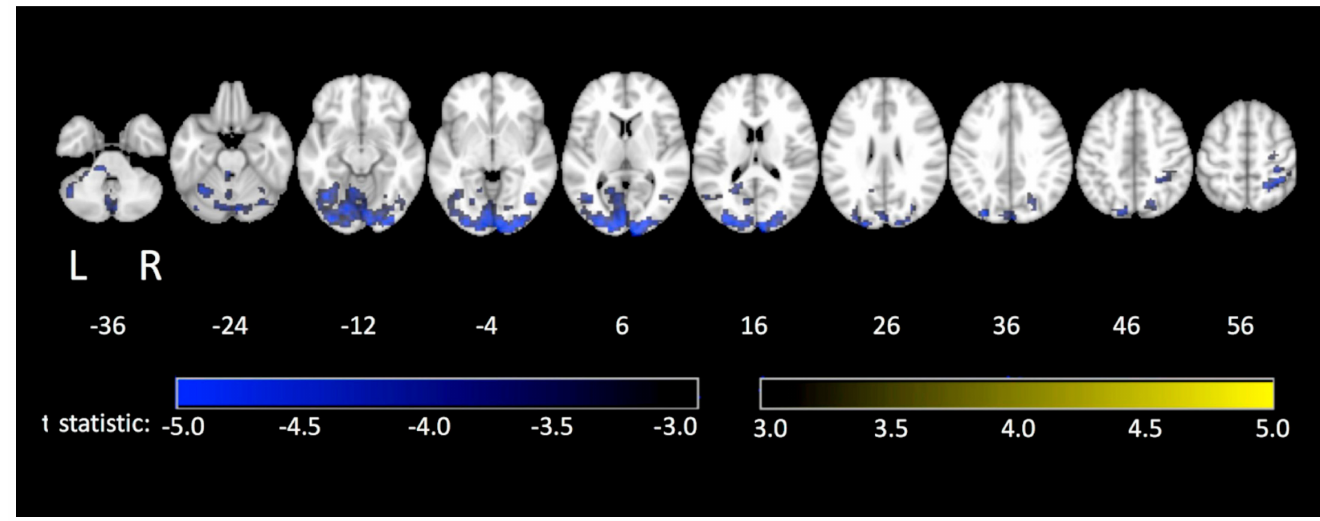
Figure 6. Regions with brain activity (TMT-A and TMT-B vs. control) that significantly covaries with age in a cohort of adults ranging from 52 to 85 years old. Numbers below the images represent the axial slice position in millimetres, in Montreal Neurological Institute (MNI) brain atlas coordinates. Taken from [41]. Copyright © 2020 Talwar et